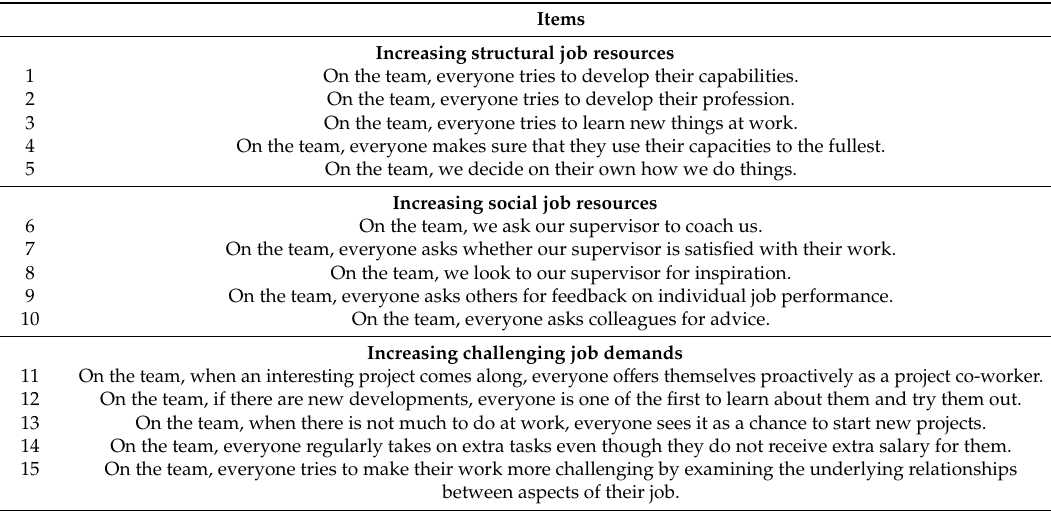
Table 4. Positive team job